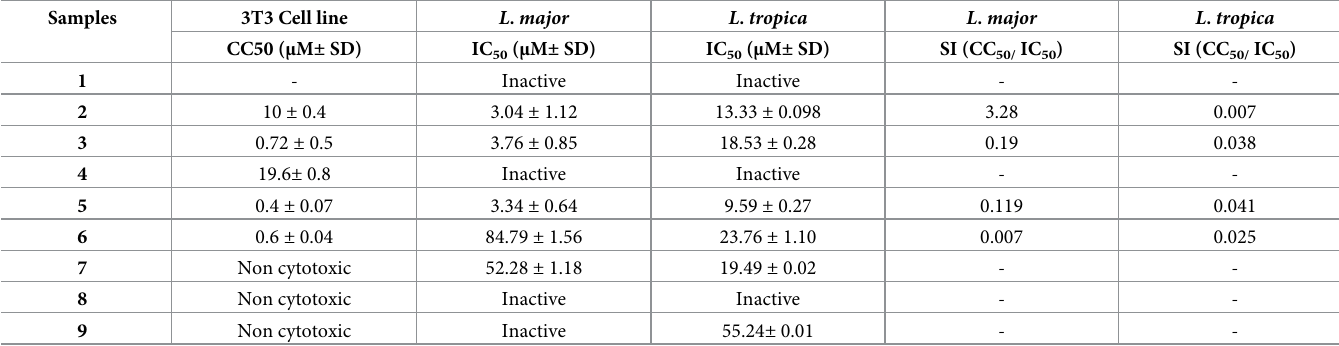
Table 6. Selectivity index of pure compounds against 3T3 mouse fibroblast cell